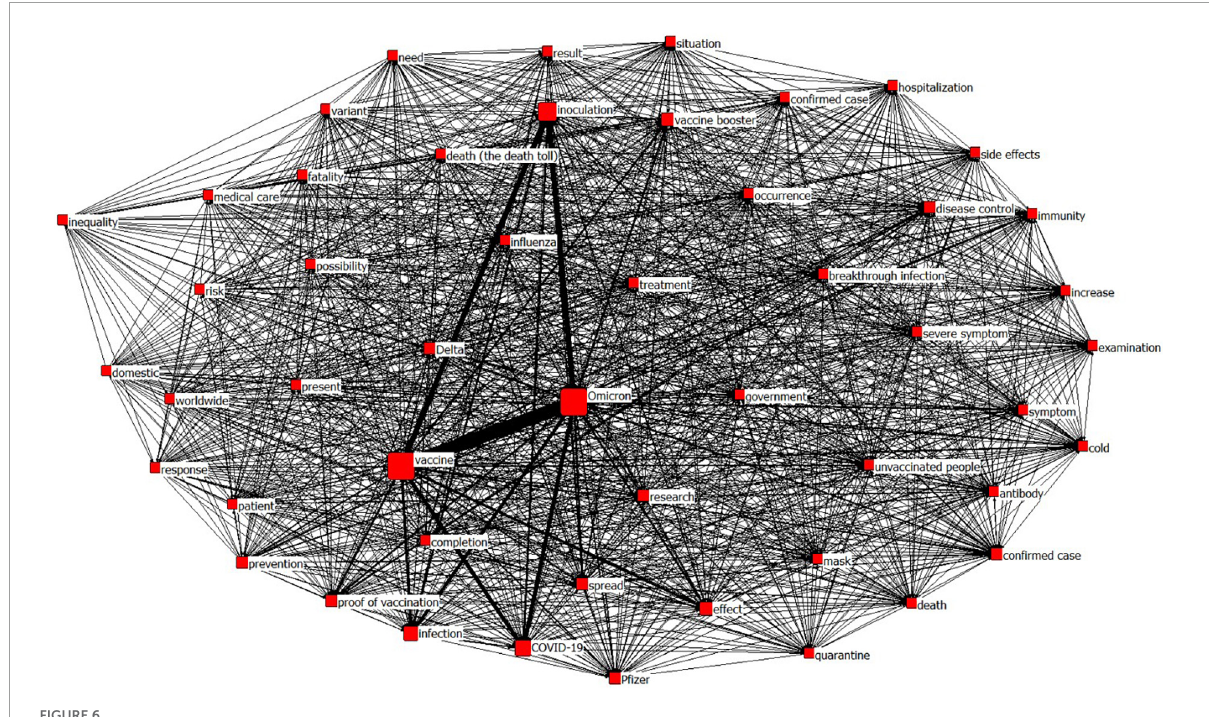
FIGURE6 Visualization of network analysis results.